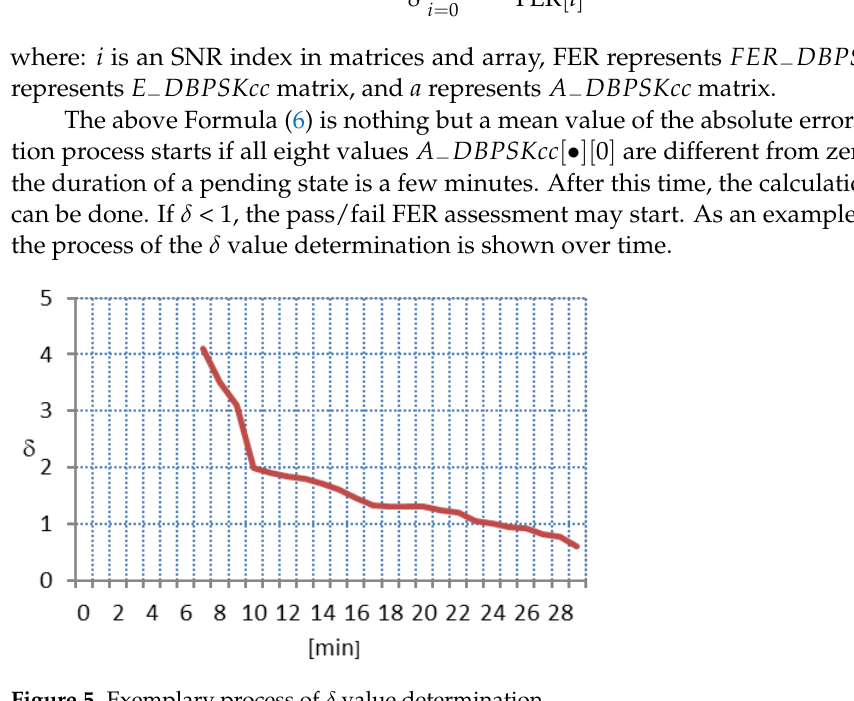
Figure 5. Exemplary process of δ value